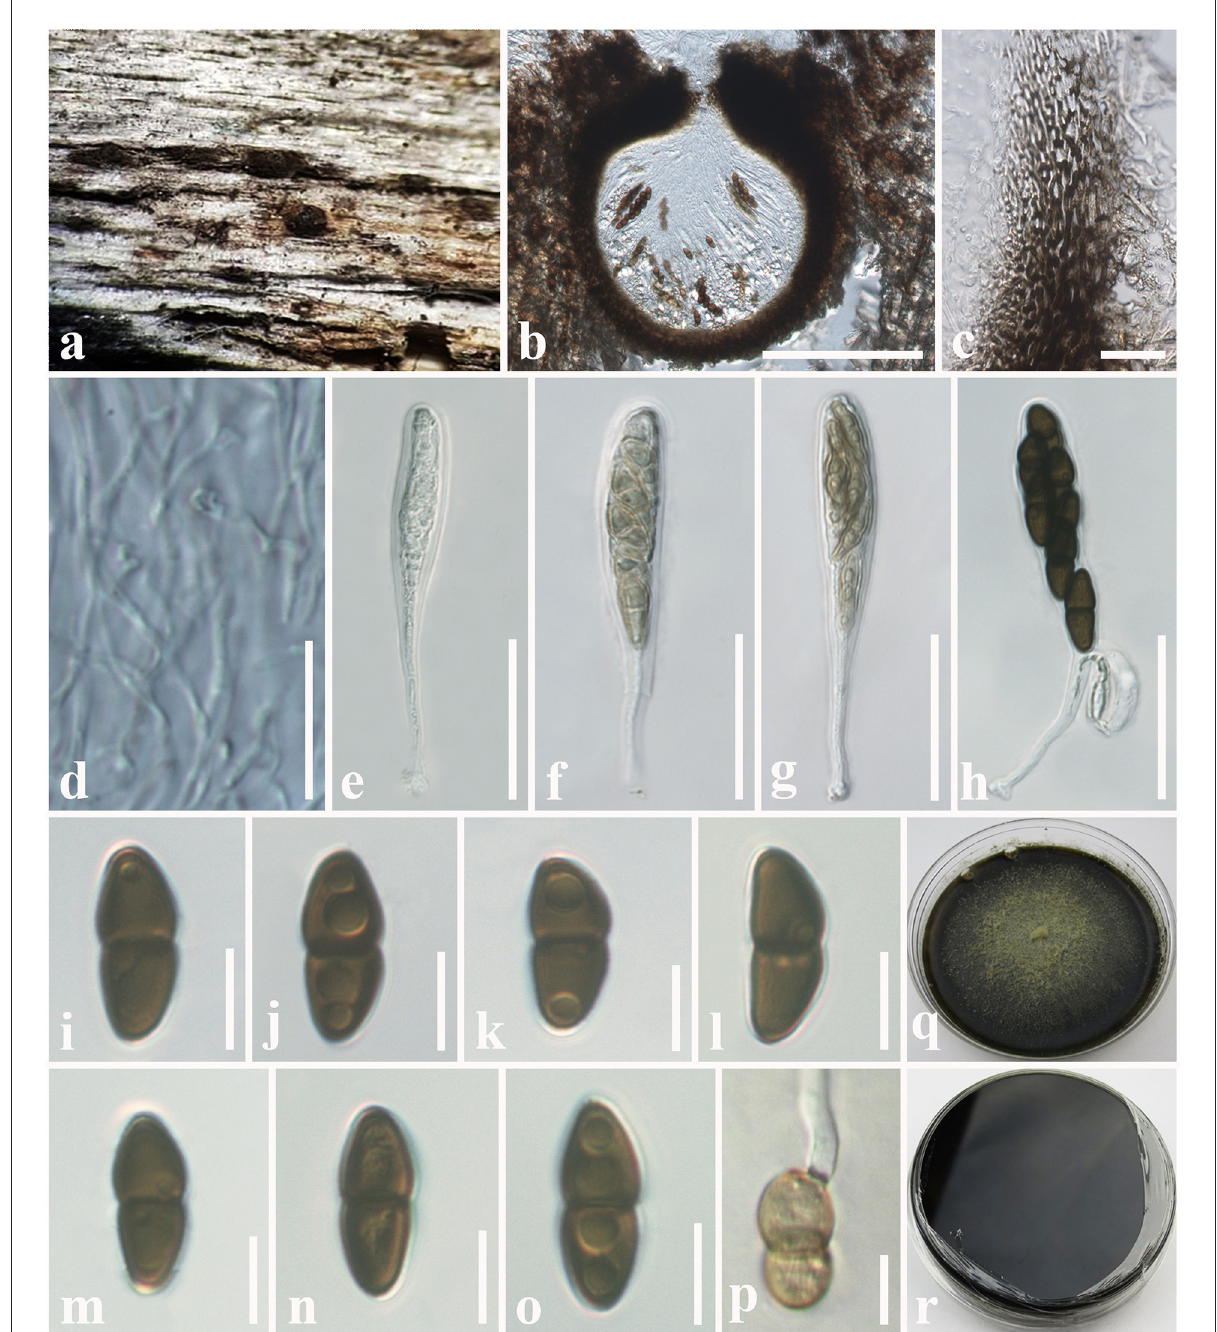
FIGURE1 Montagnula acaciae (MFLU 18-2569, holotype). (a) Ascomata on a dead stem of Acacia auriculiformis . (b) Vertical section through an ascoma. (c) Peridium. (d) Pseudoparaphyses. (e–h) Immature and mature asci. (i–o) Ascospores. (p) Germinating ascospore. (q) Upper side of the culture. (r) Lower side of the culture. Scale bars: (b) = 100 µ m, (c) = 8 µ m, (d–h) = 30 µ m, (i–p) = 5 µ m.